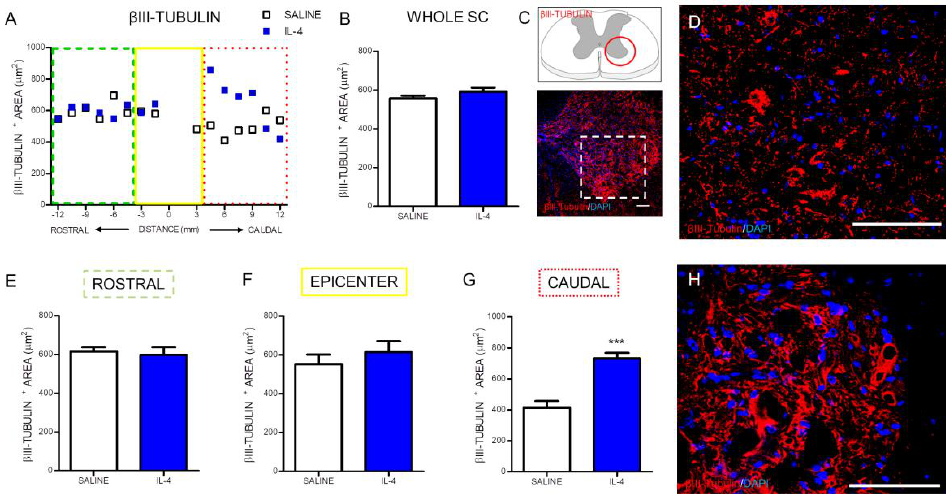
spinal cord. Distribution of β III-tubulin positive area along the rostrocaudal axis of the spinal cord ( A ); Quantification of β III-tubulin + area in the whole spinal cord did not reveal any differences between saline or IL-4 treated rats ( B ) however a significant increase of β III-tubulin area was observed in the caudal ( G ) area of the spinal cord of IL-4-treated rats; In the epicenter ( F ) and in the rostral ( E ) area no differences were observed. Schematic and low-magnification photomicrograph indicating areas where the analyses were performed (dashed lines) ( C ); Representative images of positive staining of neuronal cytoskeleton of saline ( D ) and IL-4 treated ( H ) group. Values shown as mean ± SEM. *** p < 0.001. Scale bar = 100 µ